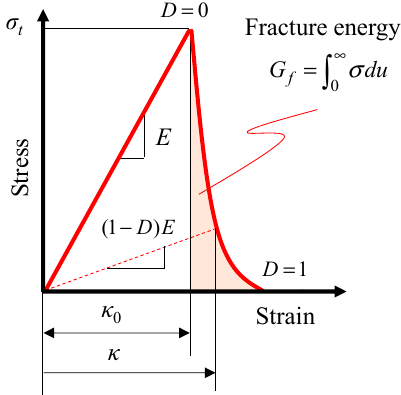
Figure 1. Schematic diagram of the stress–strain relationship in the isotropic damage model.